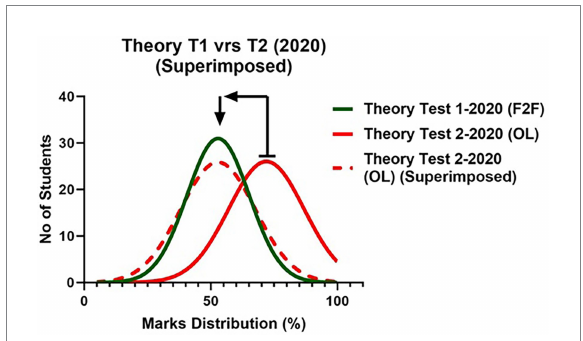
FIGURE 7 The statistical comparison shows that the shape (kurtosis) of the online marks distribution of Theory Test 2 was statistically not significantly different ( p < 0.1) from the shape of distribution of marks in theory test 1 (Face-to Face): We superimposed the two sets of data: Theory Test 1 (F2F) and theory Test 2 (OL). F2F: orthodox assessment; OL: home-based online